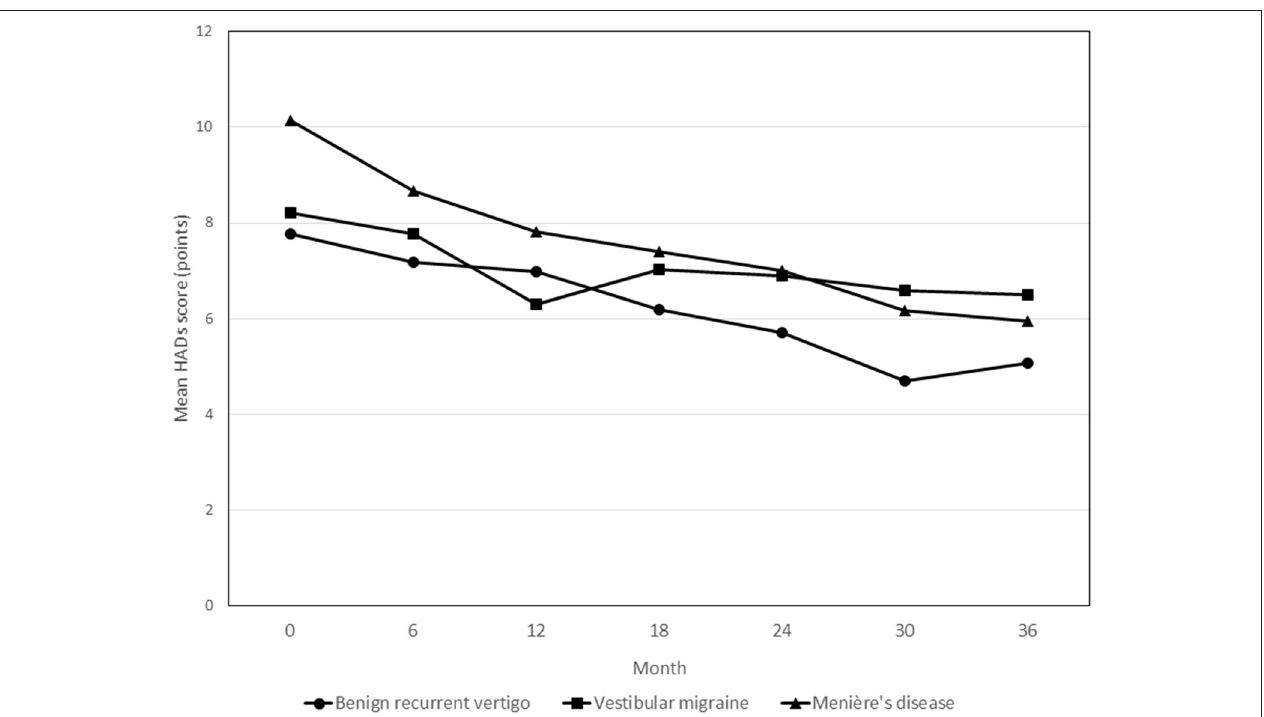
FIGURE 4 | Course of HADS scores during the 3-year follow-up period in patients with benign recurrent vertigo, vestibular migraine and Menière’s disease. None of the follow-up contact * diagnosis group interaction terms showed statistically significant differences in HADS scores. HADS, Hospital Anxiety and Depression